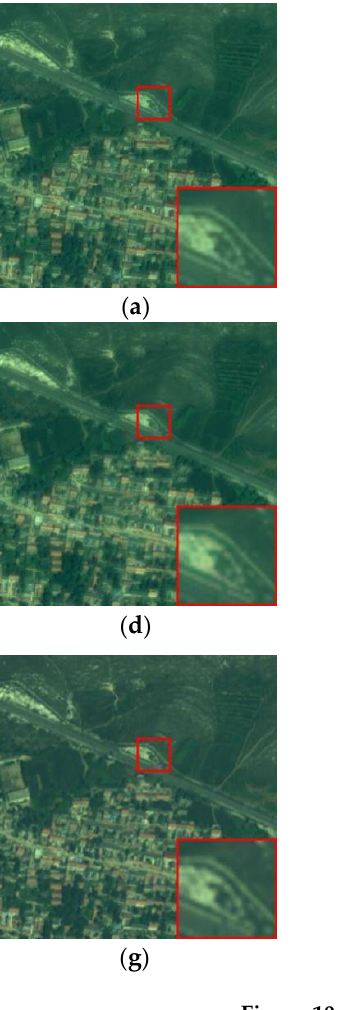
Table 7. Comparison of training and testing times on WorldView-2.